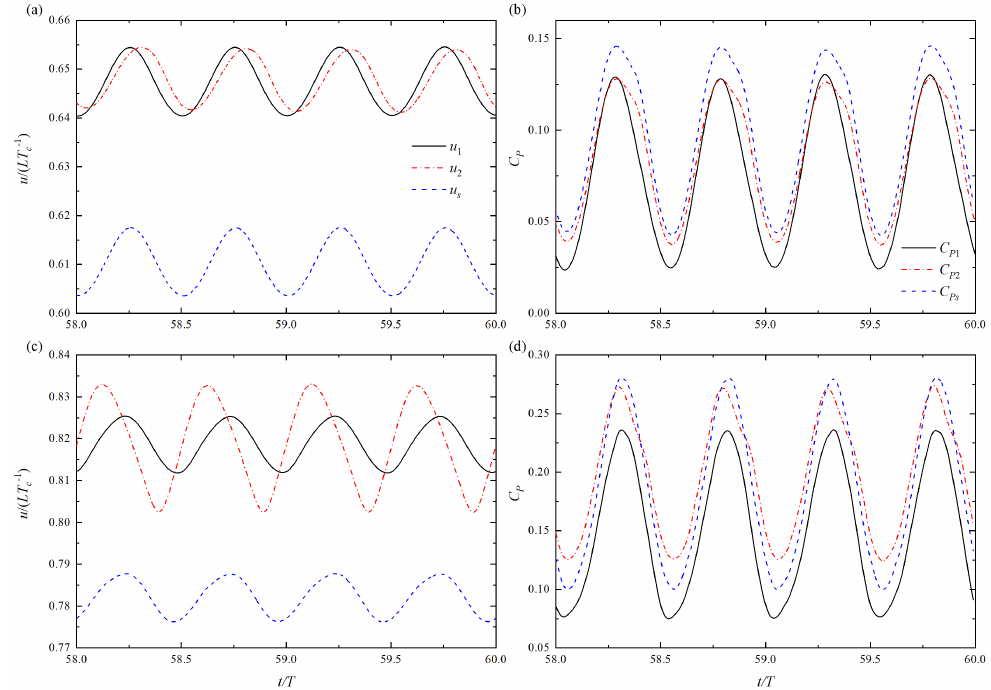
Figure 5. Time histories of swimming speed and power coefficient. ( a , b ) d 0 = 0.1 L , A = 0.1 L , and ( c , d ) d 0 = 0.5 L , A = 0.2 L . Other parameters are the same: T = 1.0 T c , λ = 1.0 L and δφ = π /2. Table 1. The overview of speed gains with all studied